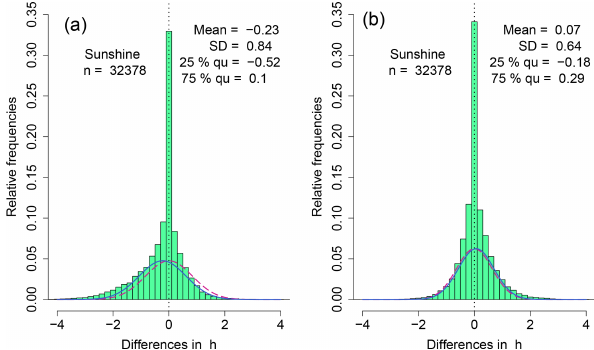
Figure 9. Differences of daily sunshine duration (automatic minus manual observations) in hours. The blue line is the normal distribu- tion used for the statistic of the differences; the pink line is a normal distribution with a mean of zero and the standard deviation accord- ing to the statistic of the differences. (a) raw data is used as shown in Fig. 1; (b) adjusted automatic measurements are